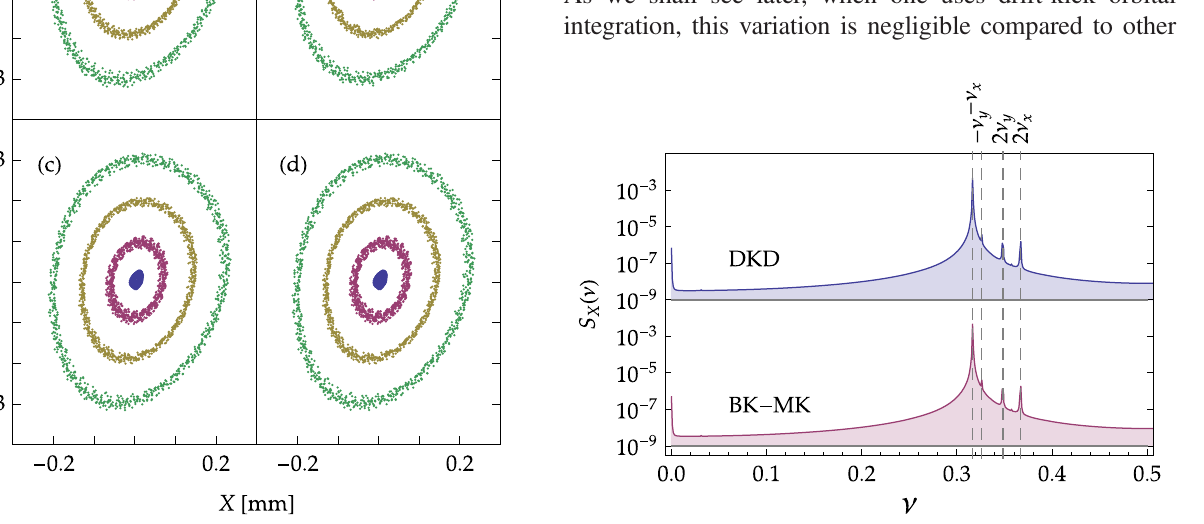
FIG. 2. Poincaré sections for four sample particles using drift- kick integration with (a) n BK/MK integration with (c) n